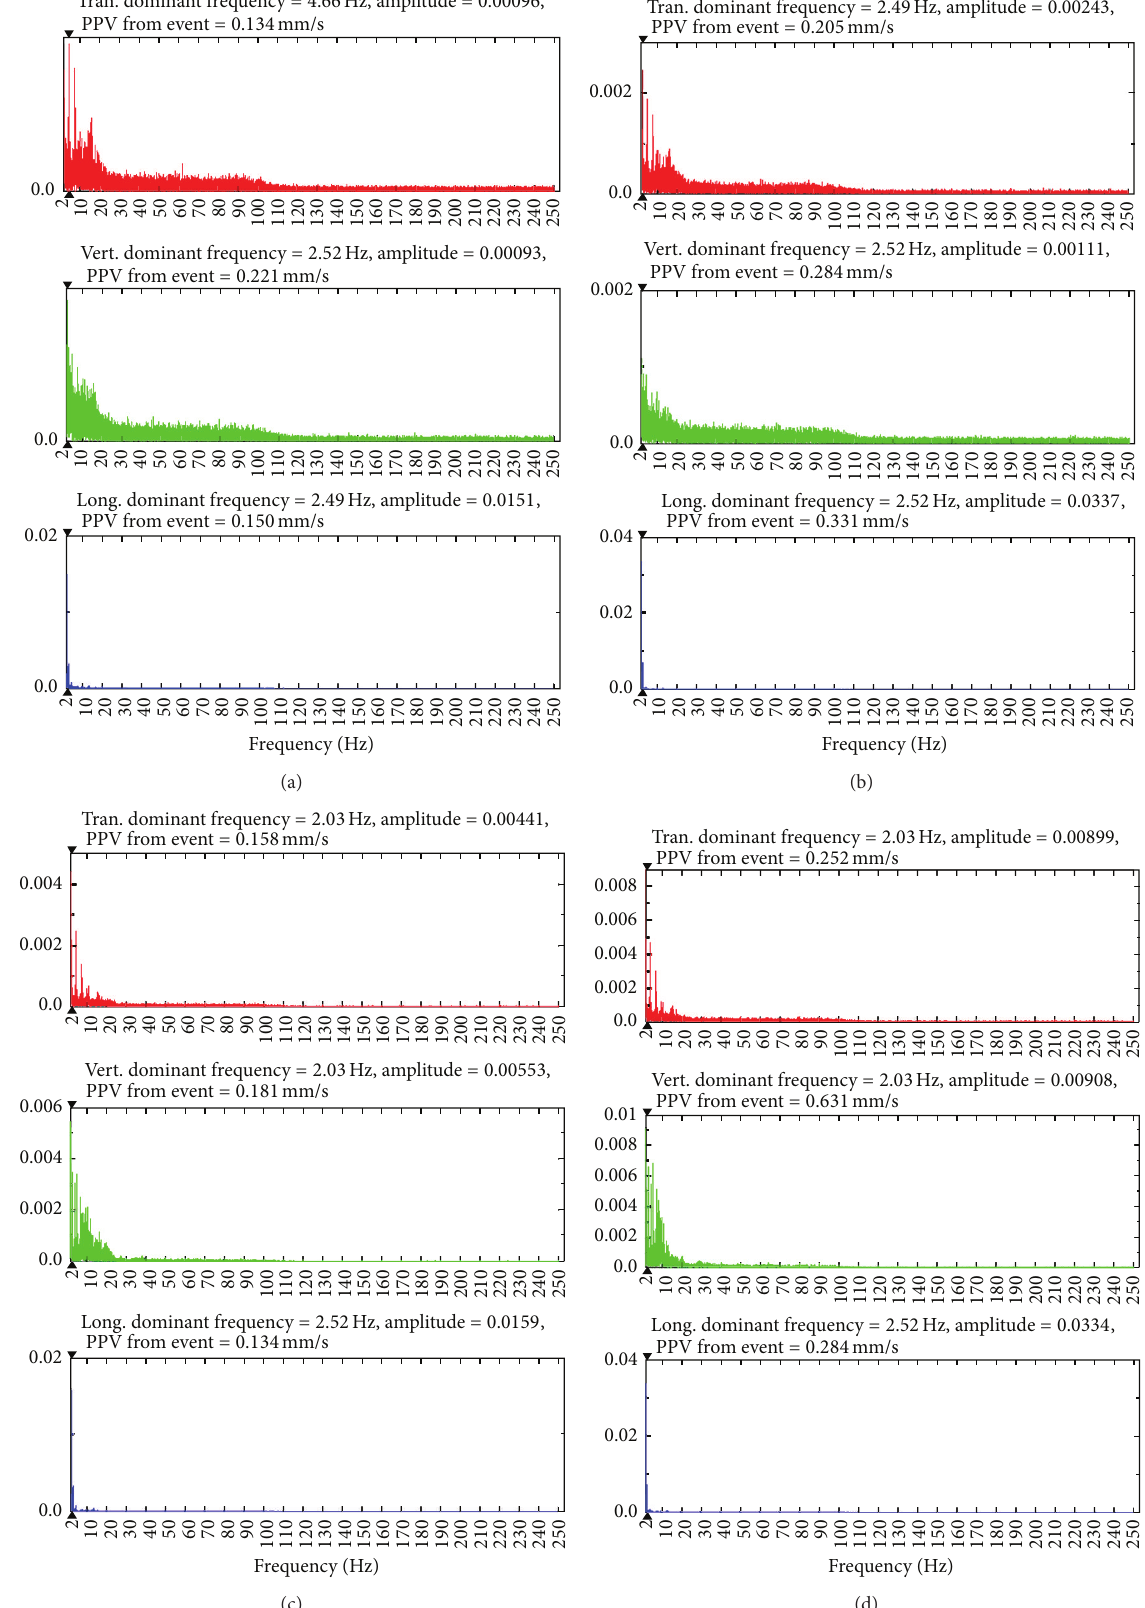
Figure 20: Frequency spectrums: (a) moveable station 1; (b) moveable station 2; (c) moveable station 3; (d) moveable station